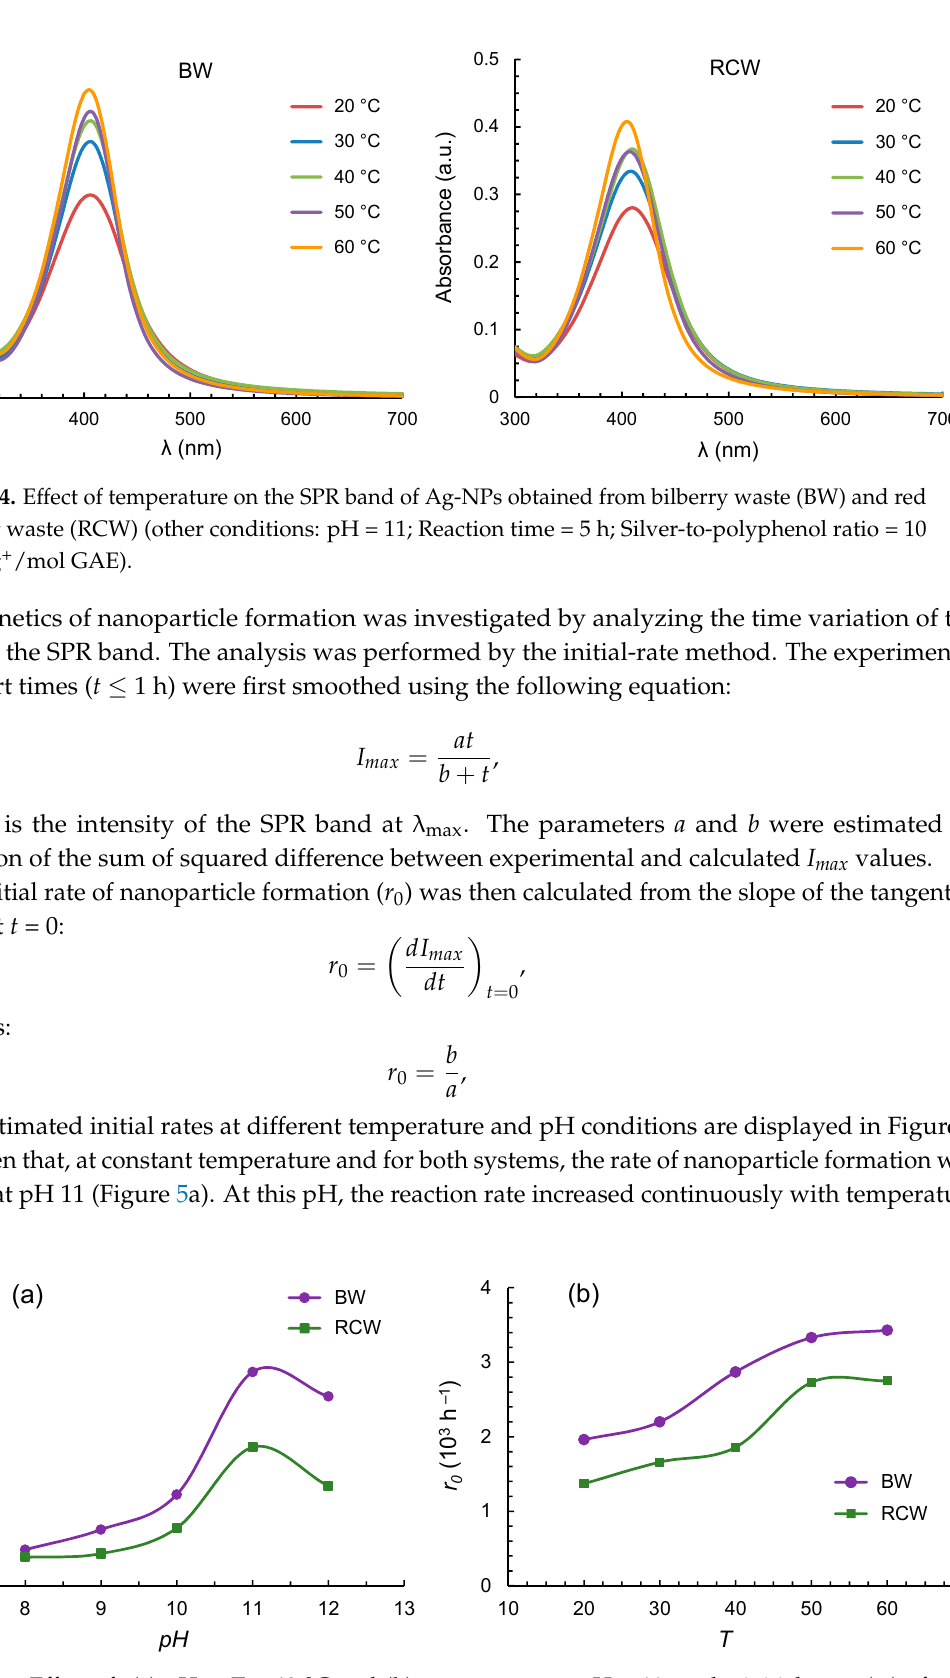
Figure 5. Effect of: ( a ) pH at T = 40 °C and ( b ) temperature at pH = 11 on the initial rates ( r 0 ) of nanoparticle production from bilberry waste (BW) and red currant waste (RCW) extracts.